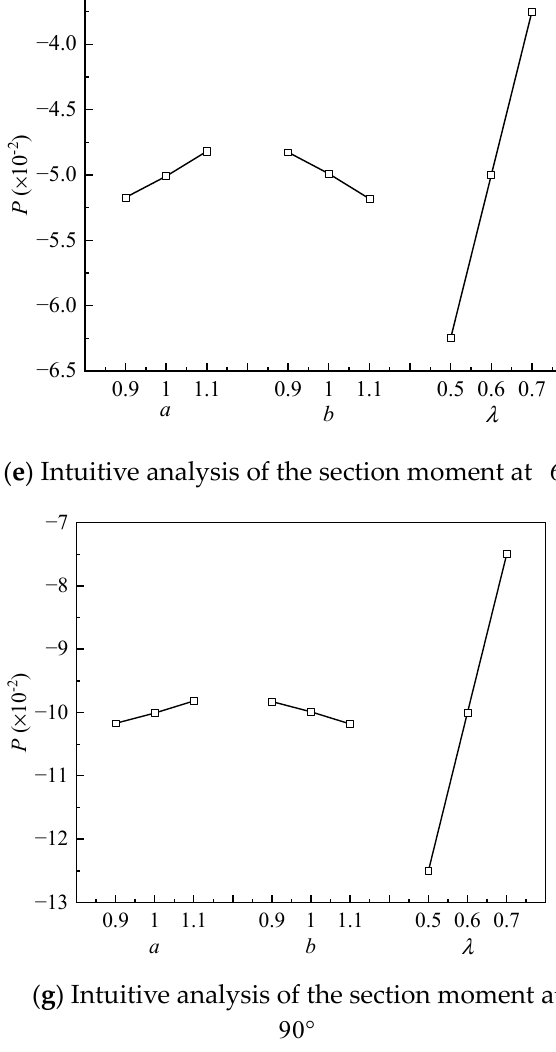
Figure 11. Intuitive analysis of influence factors of the section moment.